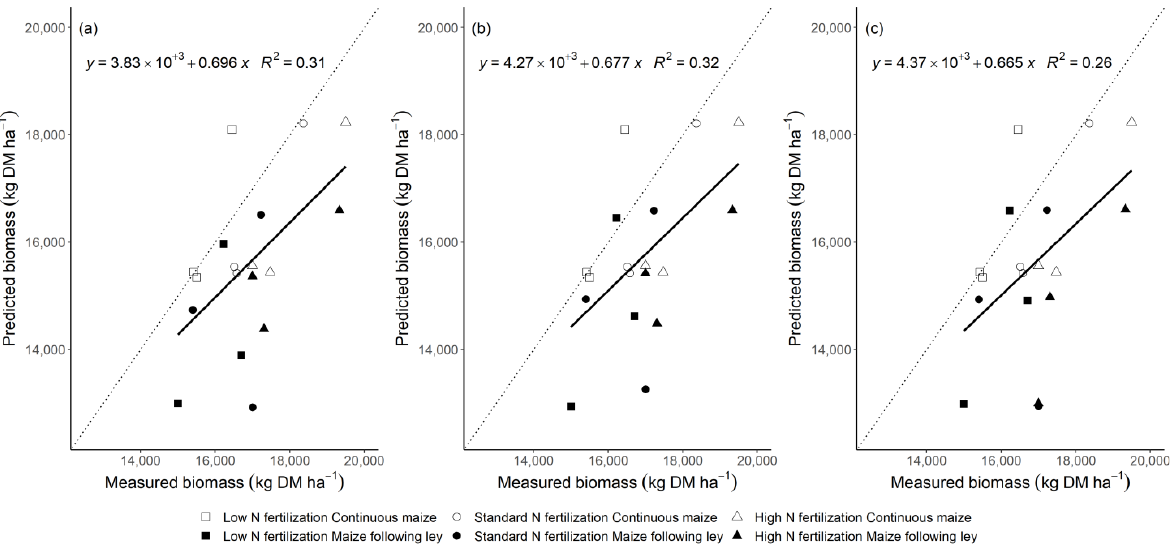
Figure 3. Measured and APSIM predicted maize biomass yield for the experimental site 2, for the low, standard, and high fertilization levels. Results are shown for the generic approach accounting for aboveground residues ( a ), above- and belowground residues ( b ), and the simple mineralization model ( c ) (see Figure 1). Table 5. Performance statistics for harvested maize dry matter (n = 6) for experimental site